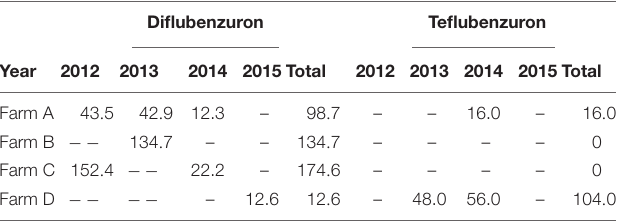
TABLE 1 | A summary of the historical use of diflubenzuron and teflubenzuron at each of the Norwegian fish farms